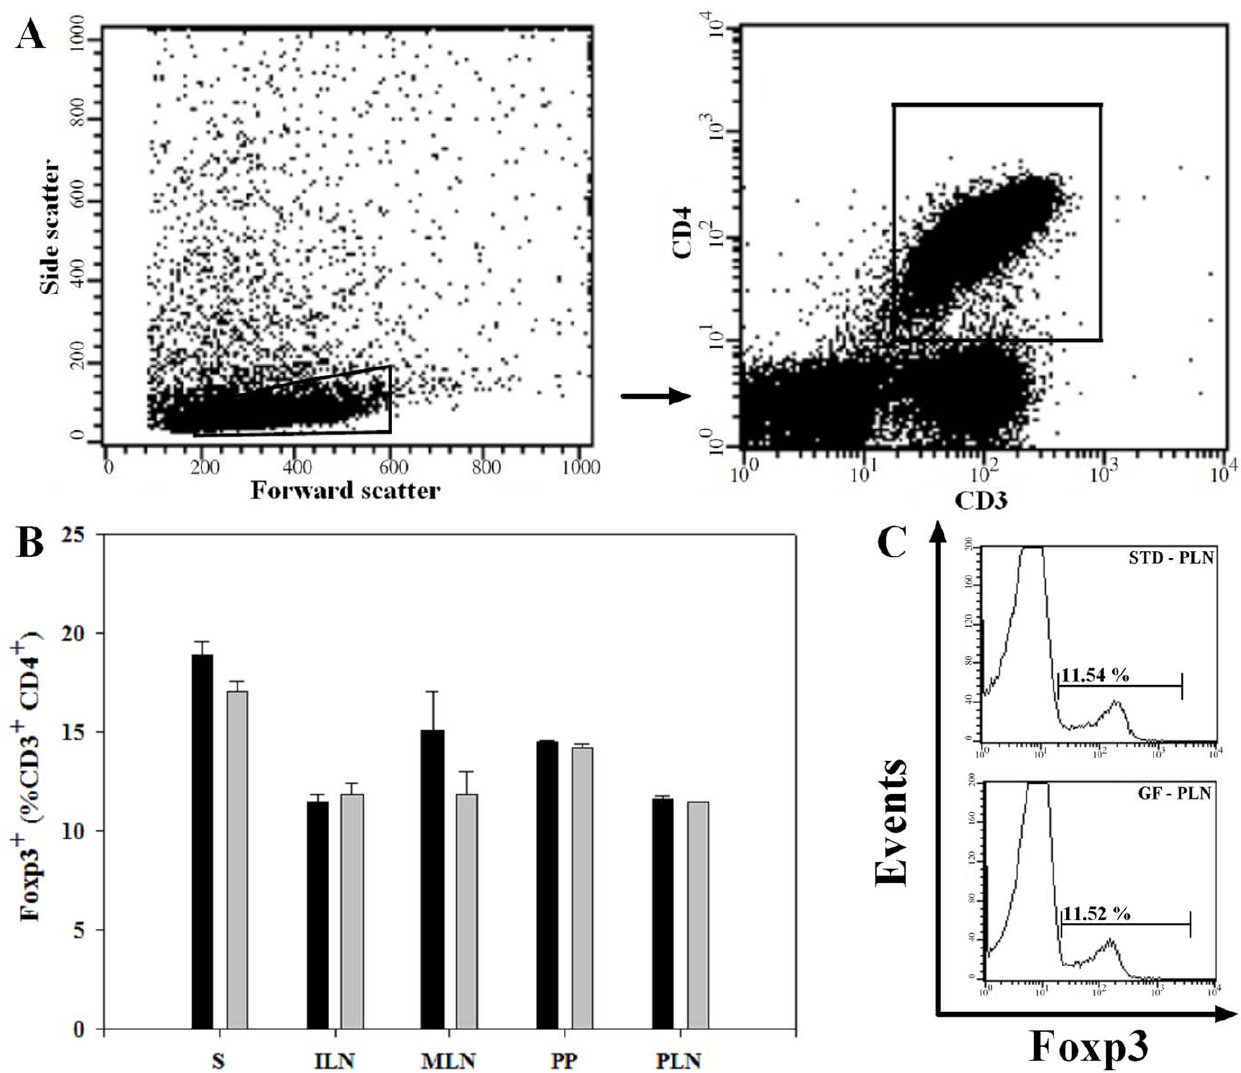
Figure 1. No diet-induced difference was found in the proportion of CD4 + Foxp3 + T cells. ( A ) Representative plot of lymphocyte and CD3 + CD4 + gate. ( B ) Bars represent the proportion of Foxp3 + cells (gated on 100% CD4 + CD3 + cells) in various lymphoid compartments. No diet- induced differences was found in the proportion of CD4 + Foxp3 + T cells in all lymphoid compartments tested. Data are presented as mean values 6 SEM of two independent experiments with 6 mice in each group. ( C ) Representative histogram from PLN, showing the proportion of CD4 + Foxp3 + T cells in the STD diet mice compared to the GF diet mice. Spleen (S); inguinal lymph nodes (ILN); mesenteric lymph nodes (MLN); Peyer’s patches (PP) and pancreatic lymph nodes (PLN). Black bars: STD diet. Grey bars: GF diet.